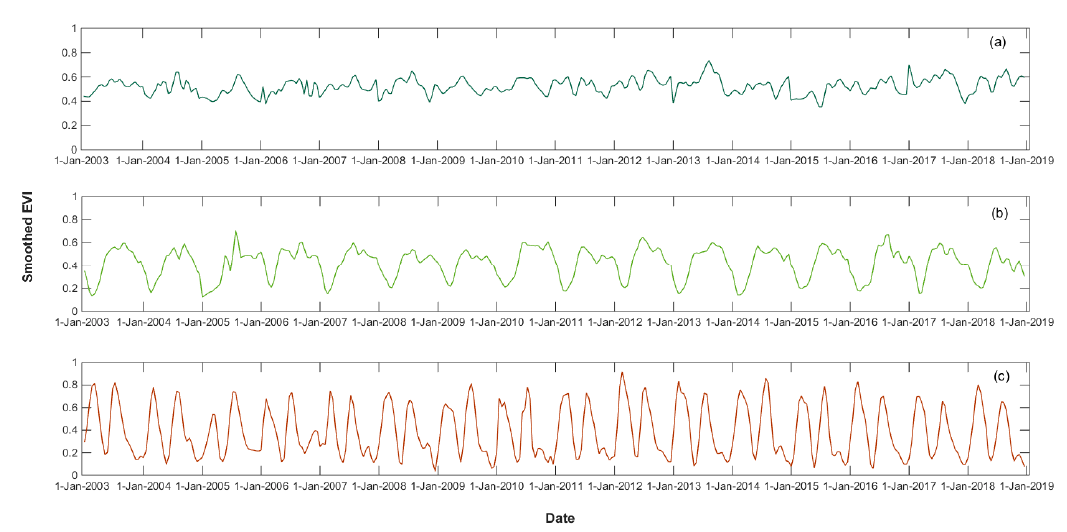
Figure 6. The 16-day EVI time series of 2-cropping-season maize before and after Savitzky–Golay filter application.